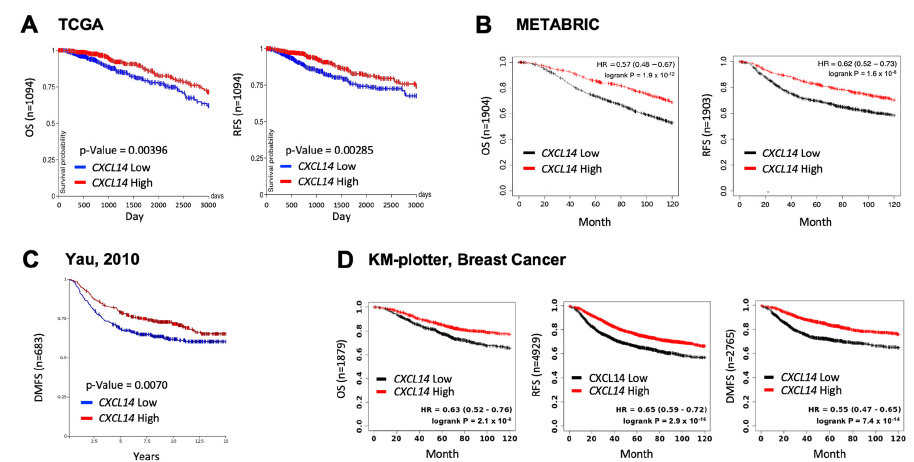
Figure 1. Correlation between CXCL14 levels and survival in patients with breast cancer. ( A ) Kaplan–Meier curves for overall survival (OS) and recurrence-free survival (RFS) between CXCL14-low and -high patients in TCGA breast-cancer dataset. ( B ) Kaplan–Meier curve for OS and RFS between CXCL14-low and -high patients in MATABRIC dataset. ( C ) Kaplan–Meier curves for distant metastasis-free survival (DMFS) between CXCL14-low and -high patients in Yau 2010 dataset. ( D ) Kaplan–Meier curves for OS, RFS, and DMFS between CXCL14-low and -high patients in the Kaplan–Meier plotter database (http://kmplot.com/analysis/index.php?p=service&cancer=breast, accessed on 4 May 2022).